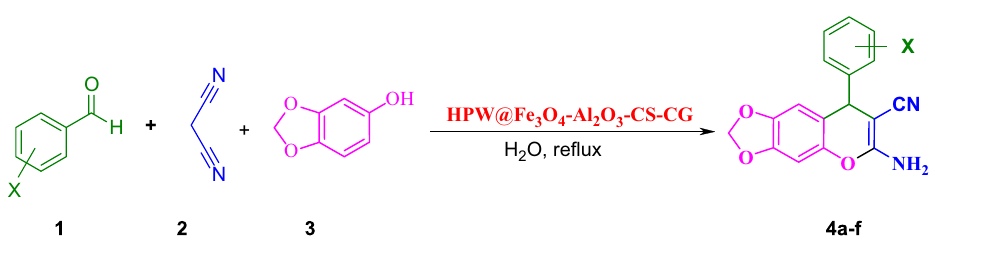
Figure 3. Synthesis of 6-amino-8-aryl-7-cyano-8 H -[1, 3]